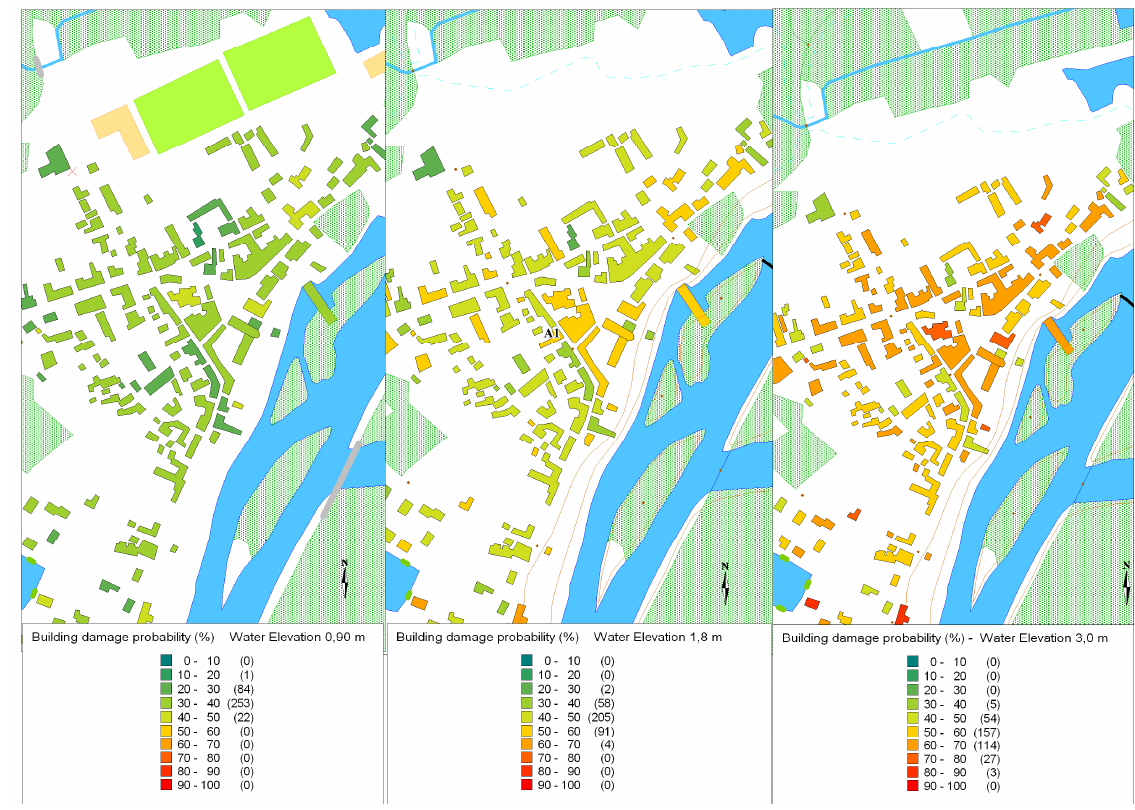
Fig. 5. Risk maps: evolution of damage failure of building for three different levels of flood hazard (hydraulic load level).